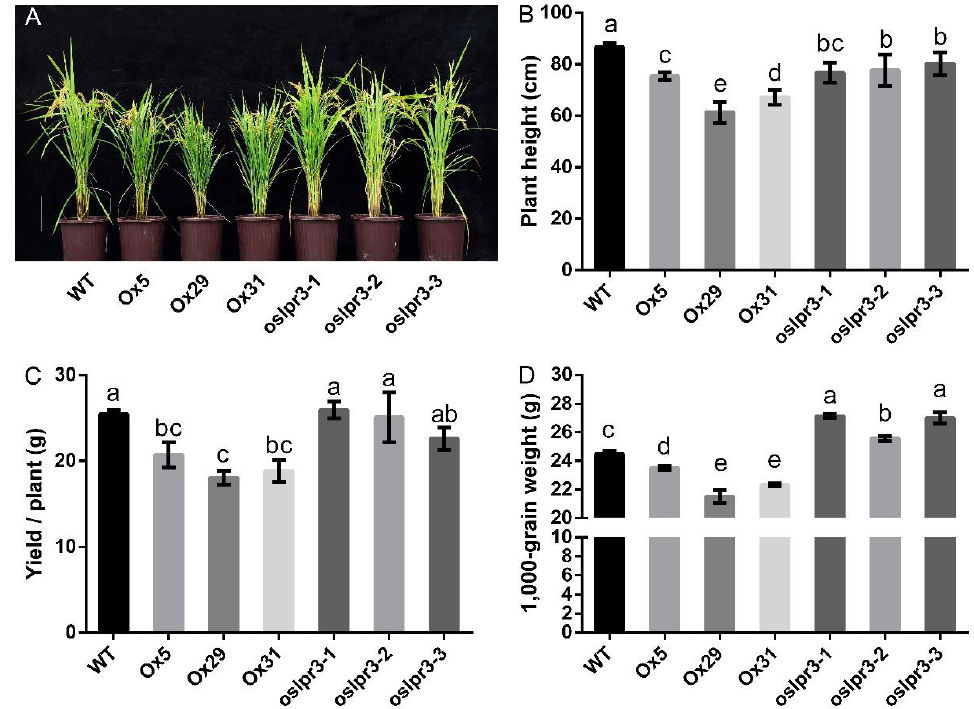
Figure 4. OsLPR3 affects growth performance and reproductive traits. WT, OsLPR3 -Ox, and oslpr3 lines were grown to maturity (20 weeks), ( A ) Photographs of the plant phenotypes. Scale bar = 20 cm. ( B – D ) Plant height, plant yield, and 1000-grain weight, respectively. Values are means ± SE ( n = 10). Different letters above the bars indicate significant differences ( p < 0.05, one-way ANOVA).